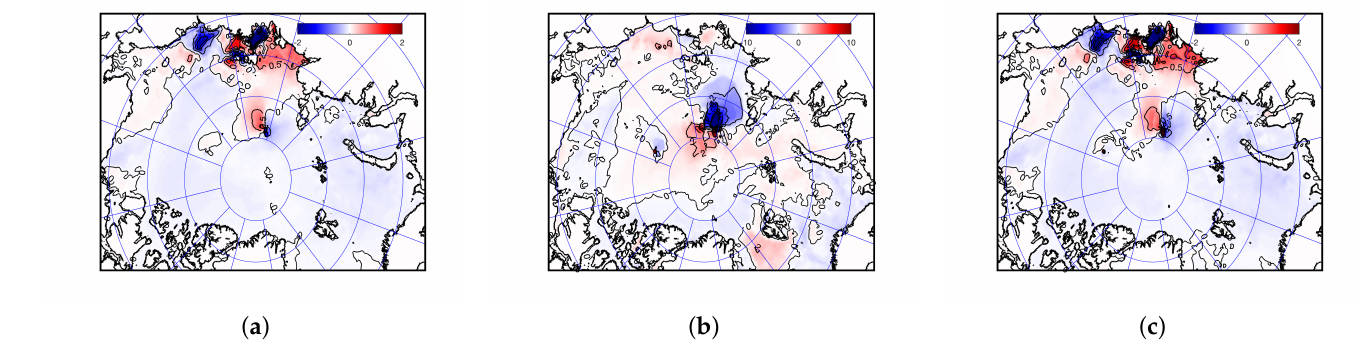
Figure 18. Annually averaged deviations in ( a ) mass of water (kg/m 2 ), ( b ) its heat content (MJ/m 2 ), and ( c ) mass of salt (kg/m 2 ) per square meter of the Arctic area (above 65 N), obtained as a result of vertical integration from the surface to the ocean floor in terms of incremental values in numerical experiment C2 to experiment